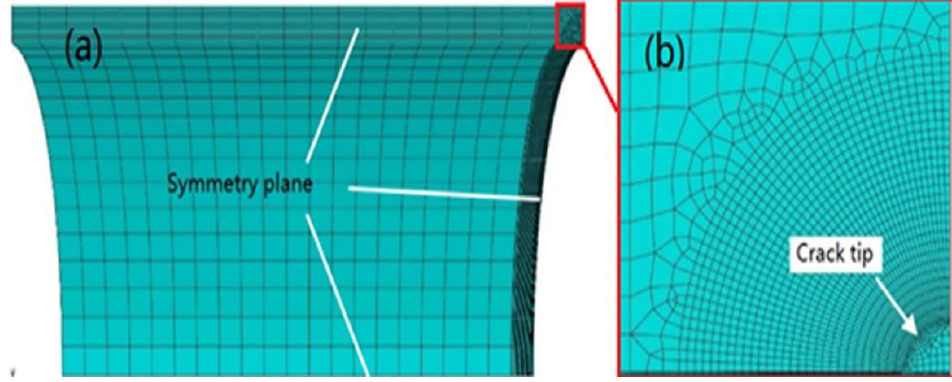
Figure 12. The FE model ( a ) and local mesh distribution around the crack tip ( b ).